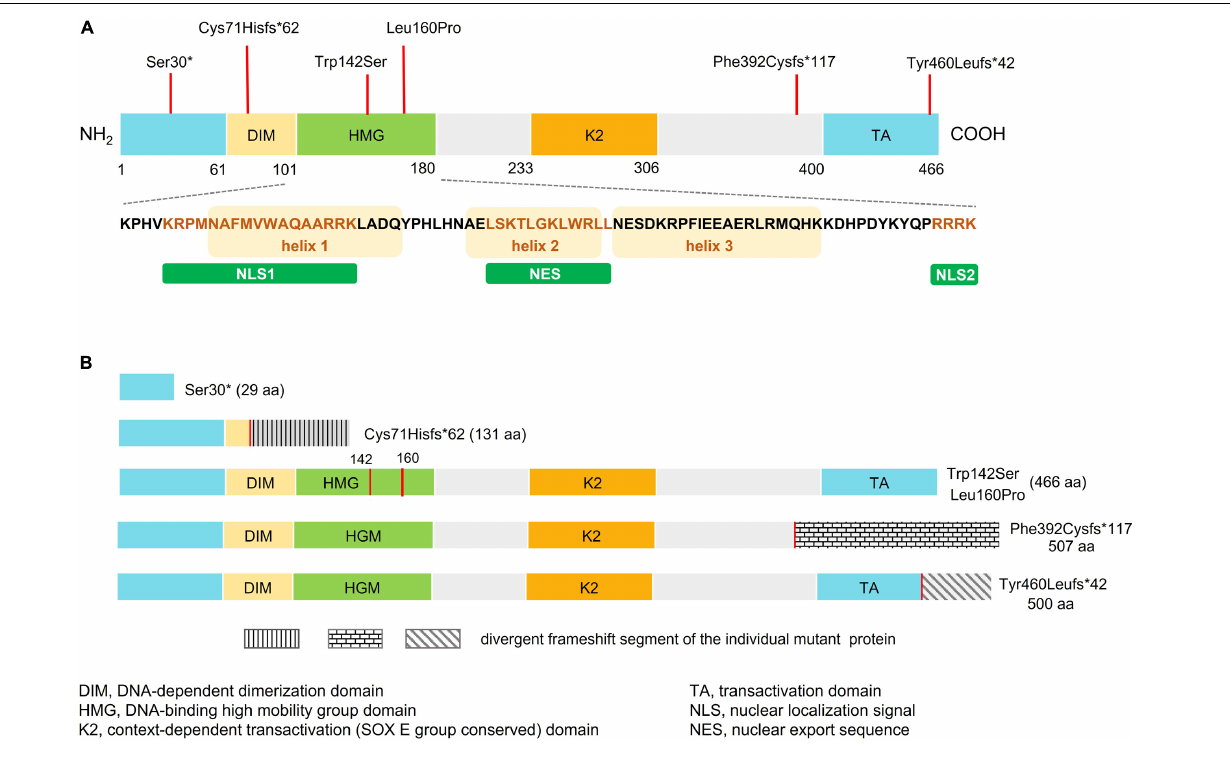
FIGURE 1 | Schematic representation of wild-type and mutant SOX10. (A) Domain structure of SOX10 showing dimerized domain (DIM), high mobility group domain (HMG), and C-terminal transactivation (TA) domain. Bottom panel shows amino acid sequence of the HMG domain, three alpha-helical domains, two NLSs (NLS1 and NLS2), and the nuclear export sequence (NES). The orange box represents the helix fragment while the different colored text represents sequence of the NLS1, NES, and NLS2. Location of the SOX10 mutations identified in this study are indicated by red vertical lines above the domain structure. (B) Predicted domain structure of each mutant